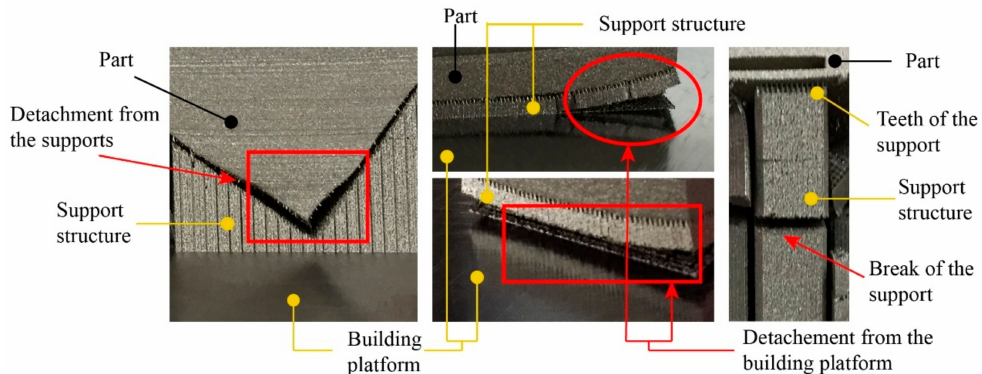
Figure 1. Detachment of the supports from the part ( left ), distortion caused by the detachment of the supports anchored to the part by the building platform ( center ), and breaking of the support ( right ) during the manufacturing of a component in nickel alloy